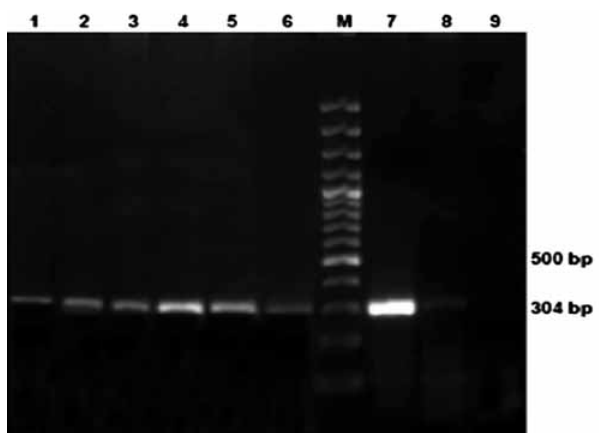
Figure-1: Concentration of rotavirus by various methods; Lane M: 100 bp plus ladder, Lane 1-3 proteinase K concentration method (10 to the power 9, 10 to the power 8 and 10 to the power 7 viral paricles/ml), Lane 4-6 concenteration by lysis buffer (10 to the power 9 10 to the power 8 and 10 to the power 7 viral paricles/ml), Lane 7-9 concenteration by PEG 8000 (10 to the power 9, 10 to the power 8 and 10 to the power 7 viral